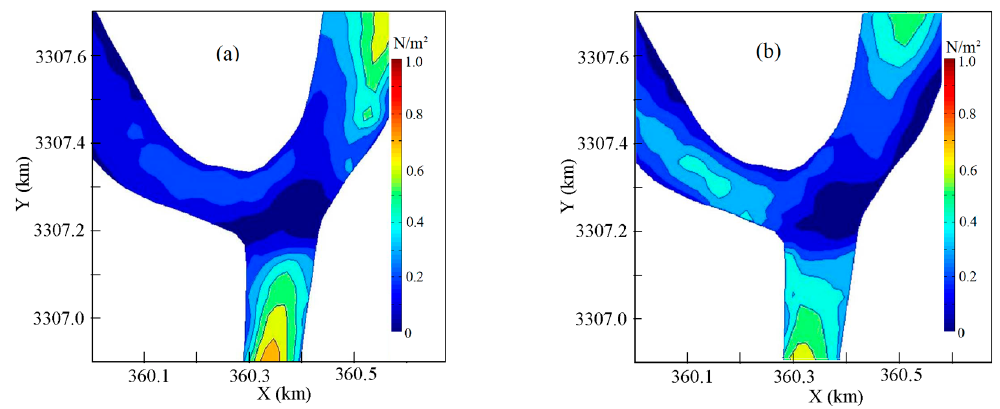
Figure 16. Distributions of 𝜏 (cid:3029) (cid:4652)(cid:4652)(cid:4652)⃗ during the second half of June 2015: ( a ) At the maximum flood tide; ( b ) At the maximum ebb tide. ( b ) At the maximum ebb